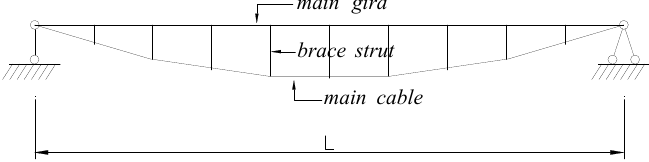
Figure 1. Structural characteristics of the tensioned string bridge.